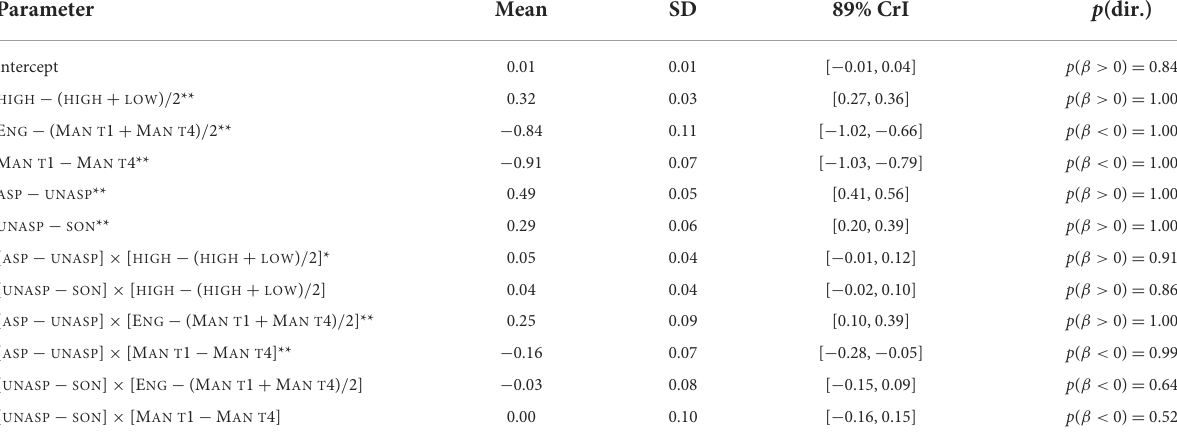
TABLE 3 Marginal posterior summaries for key population-level parameters from M6.